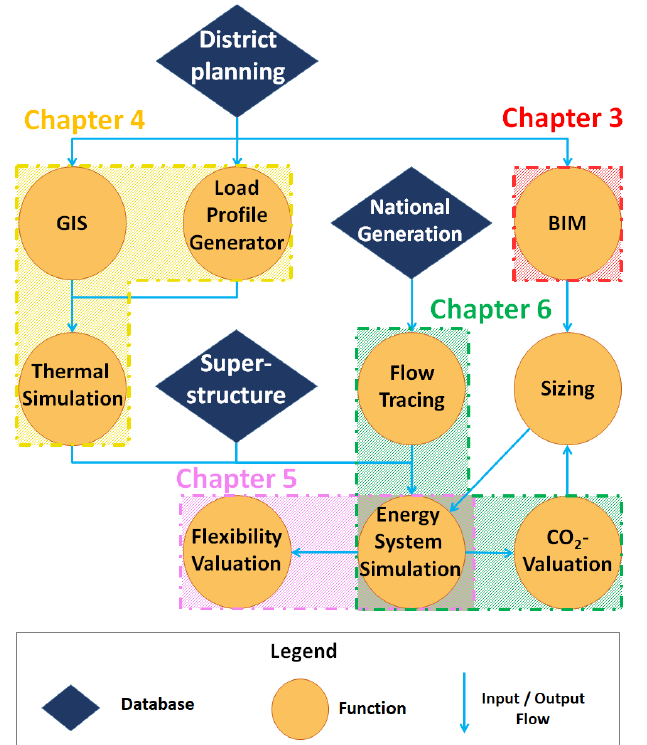
Figure 1. Interfaces between the main aspects of this paper and the system simulation described in Reference